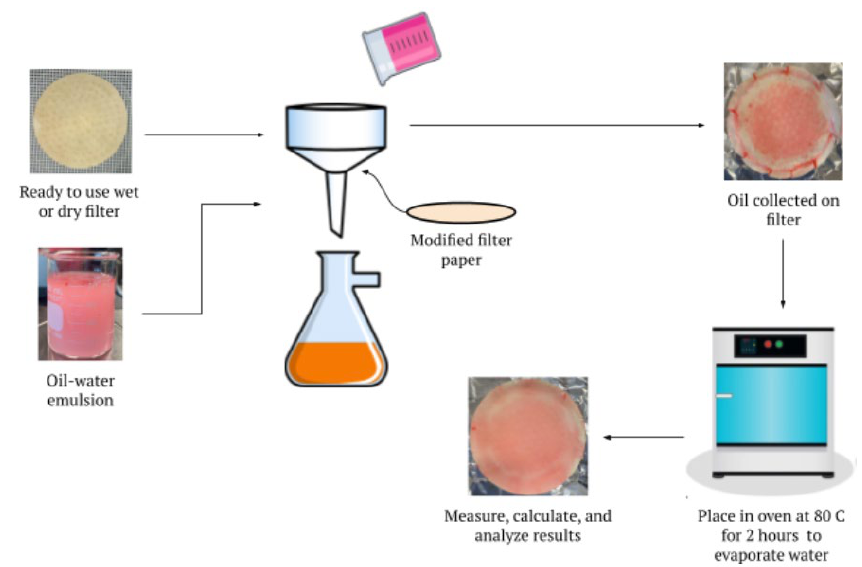
Figure 2. Summary of oil-water separation process using vacuum filtration.